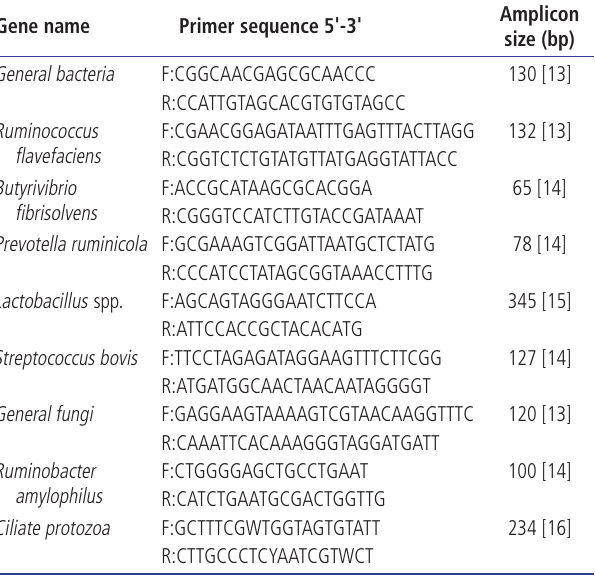
Table 2. Primer used for the real-time polymerase chain reaction